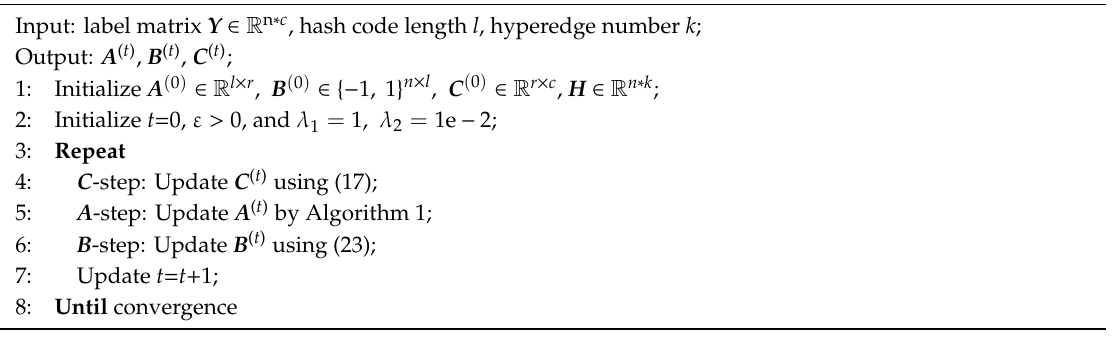
Algorithm 2 Low-Rank Hypergraph